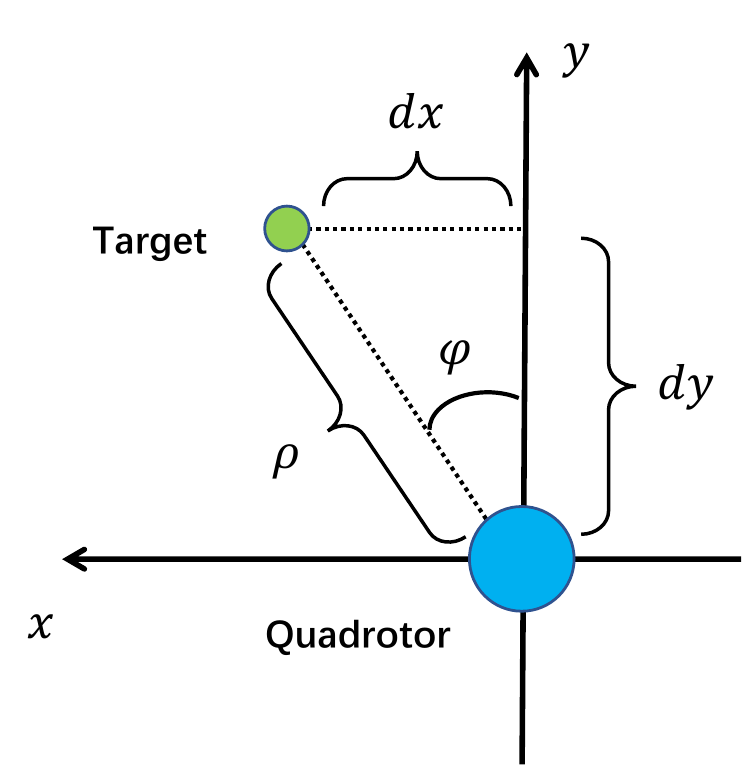
Figure 4. An aerial view of the quadrotor and dynamic target in the training